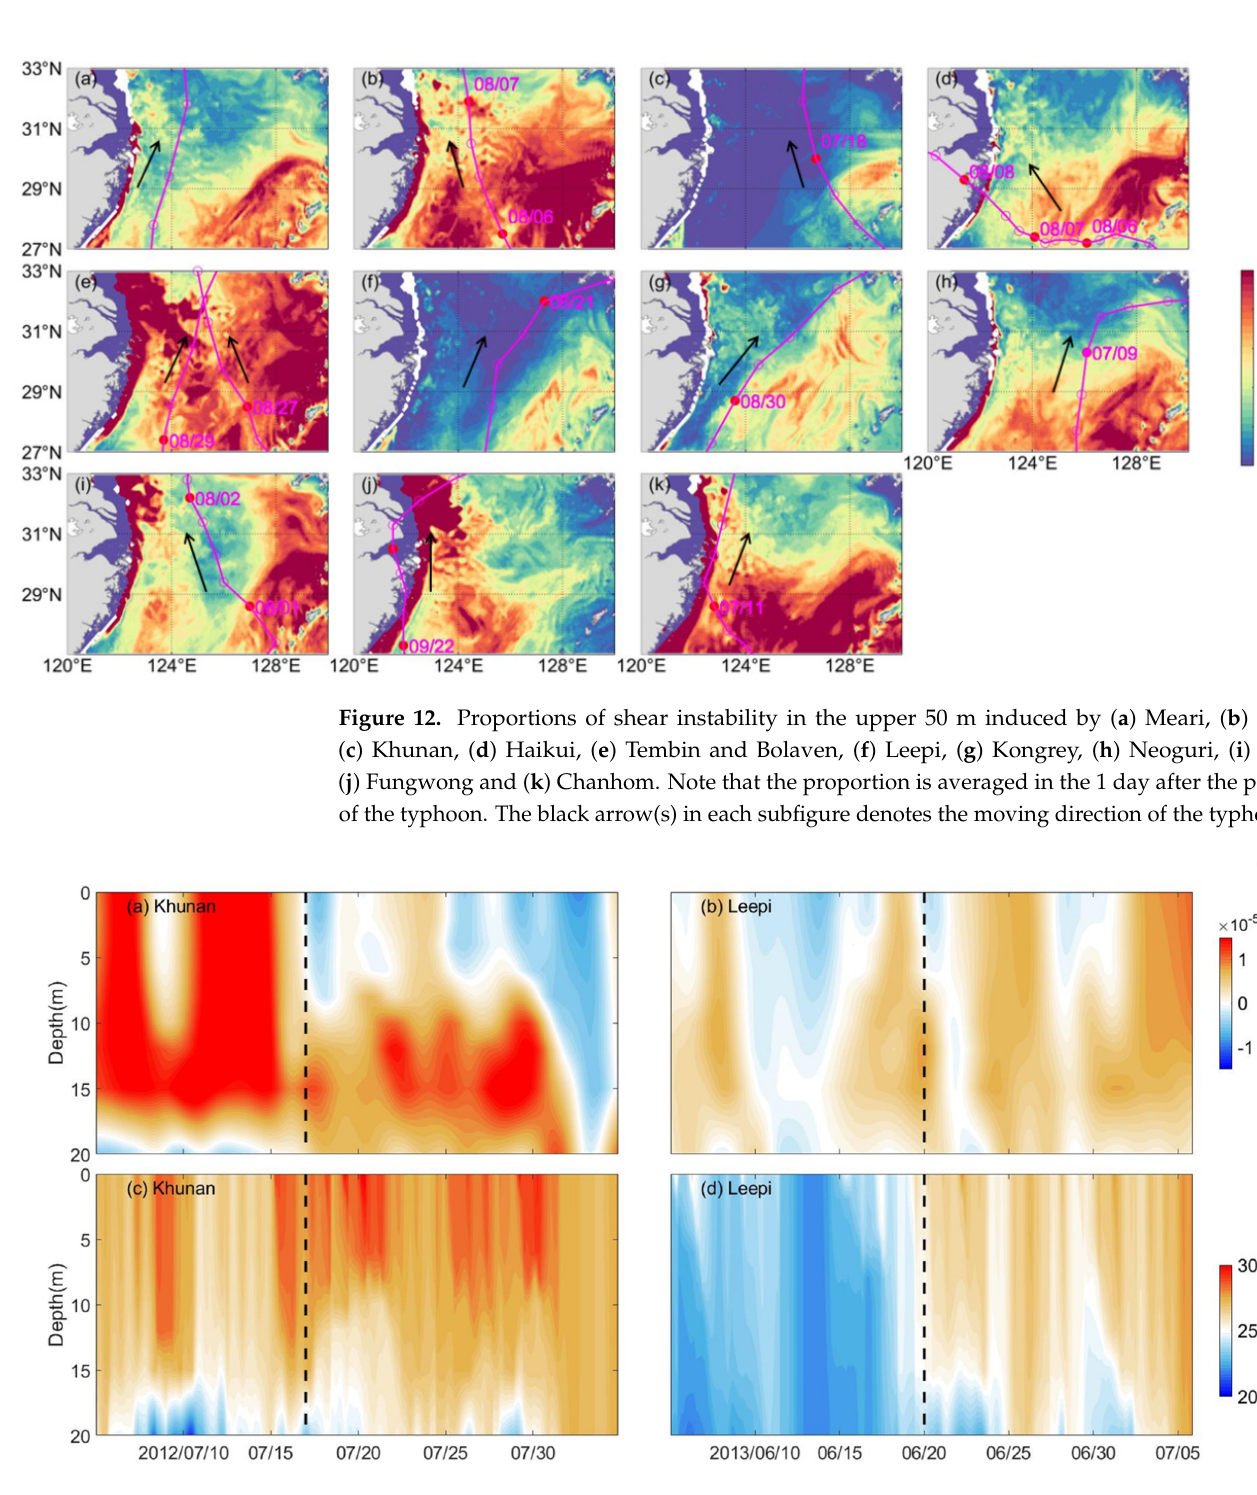
Figure 13. ( a , b ) Divergence of horizontal velocities and ( c , d ) water temperature at (28° N, 121.76° E) for ( a , c ) Khunan and ( b , d ) Leepi. In each subfigure, the vertical dashed line denotes the time when the typhoon passed.